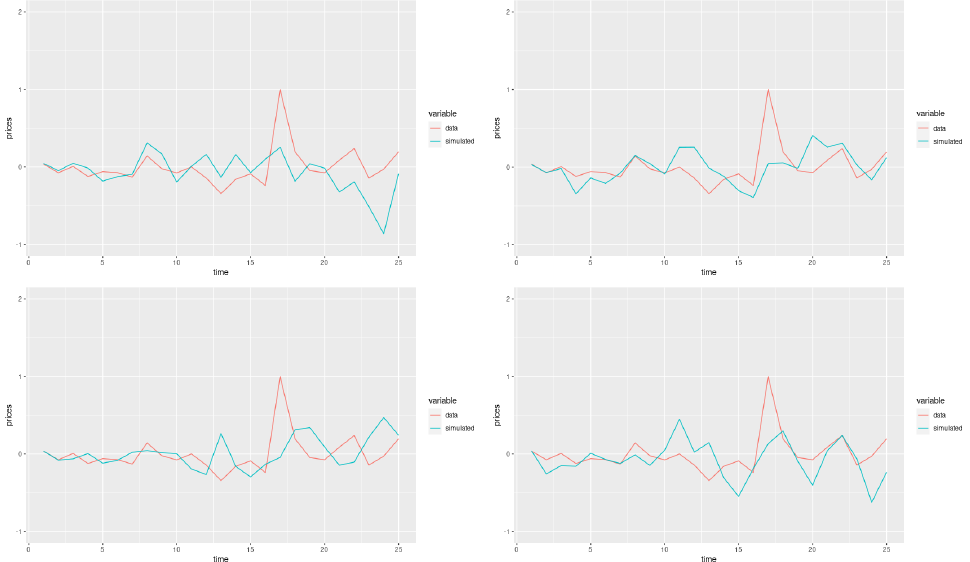
Figure A2. Price trajectories generated by the model (54) vs. the option prices on copper futures. Temporal range: from 1 February 2021 to 25 January 2022. Fifty strikes + / − : 340 call ( top left ), 340 put ( top right ), 345 call ( bottom left ), and 345 put ( bottom right